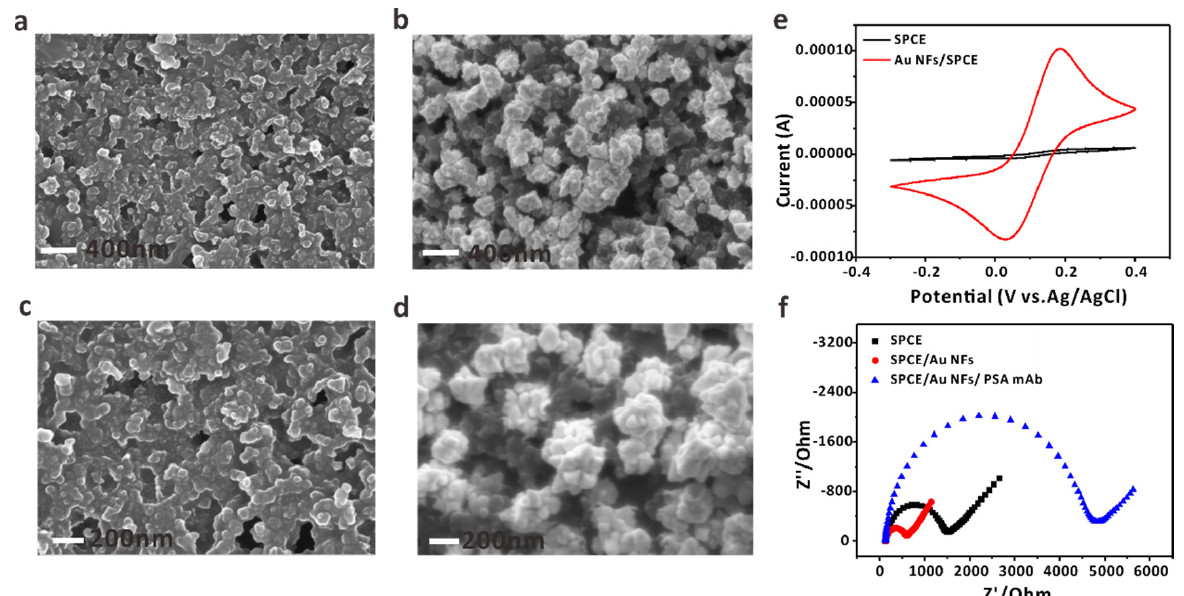
Figure 1. ( a , b ) SEM images of SPCE surfaces at different magnifications. ( c , d ) SEM images of Au NFs/SPCE surfaces at different magnifications. ( e ) CV characterization of SPCE and Au NFs/SPCE. ( f ) The EIS characterization of different modified electrodes. The CV and EIS experiments were performed in 0.1 M PBS solution containing 5 mM Fe (CN) 6 3 − /4 − .